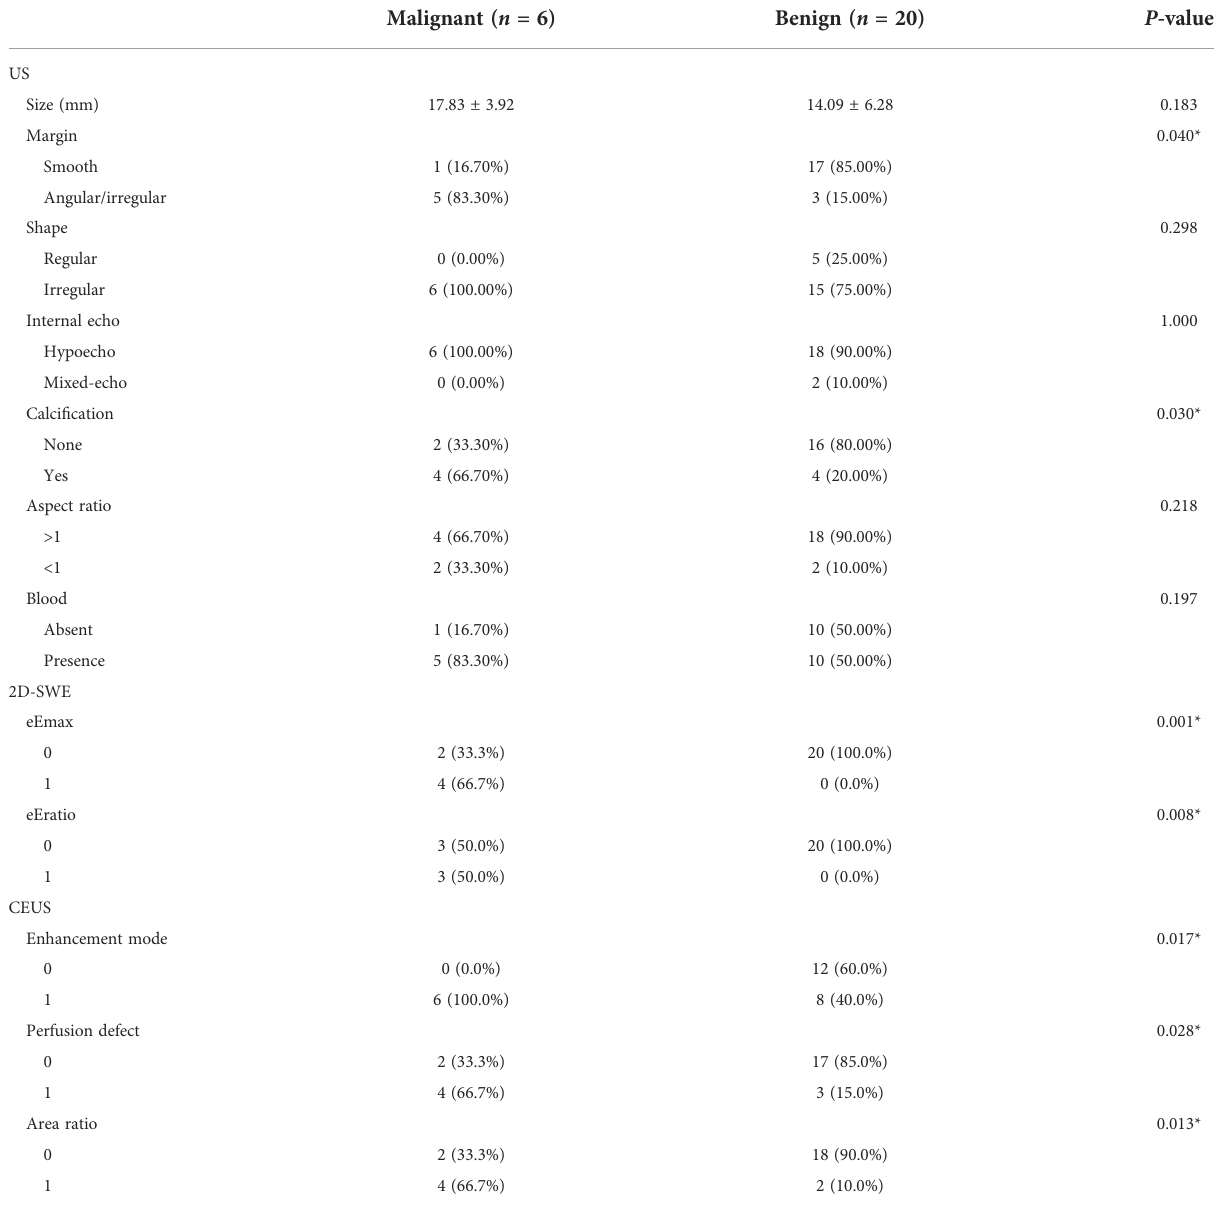
TABLE 6 Ultrasonographic features of category BI-RADS 4 breast neoplasms in the validation